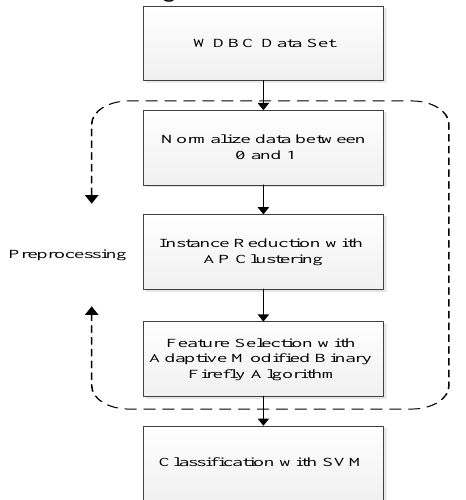
Figure 1. The proposed hybrid approach for breast cancer classification.